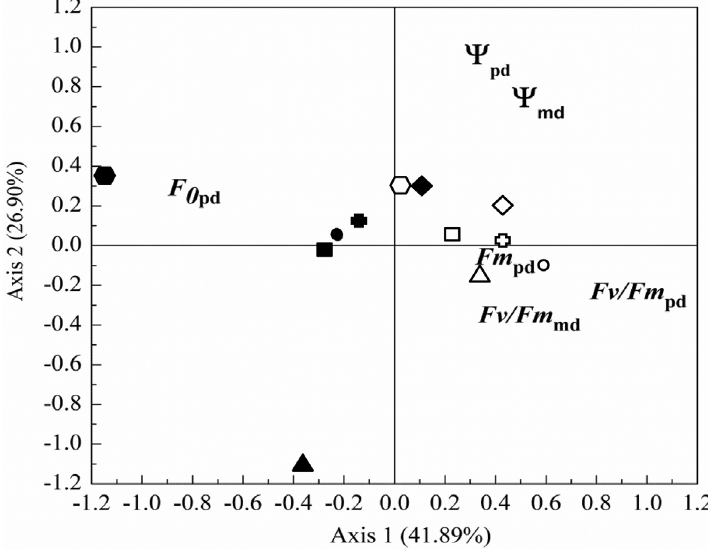
Figure 4 - PCA ordination of six species in two seasons on the basis of six traits: predawn ( Ψ ) and midday leaf water potential ( Ψ ), predawn ( F / pd md v F ), midday chlorophyll fl uorescence ( F /F ), predawn basal ( F ) and m pd v m md 0 pd maximum fl uorescence yield ( F ). Each species, in the wet and dry seasons m pd (open and closed symbols, respectively) are represented as follows: Byrsonima (cross), Clusia (circles), Eugenia (hexagon), Erythroxylym (triangle), Protium (losangle) and Ocotea (square). Axis 1 and 2 represent 41.89% and 26.90% of total variance,